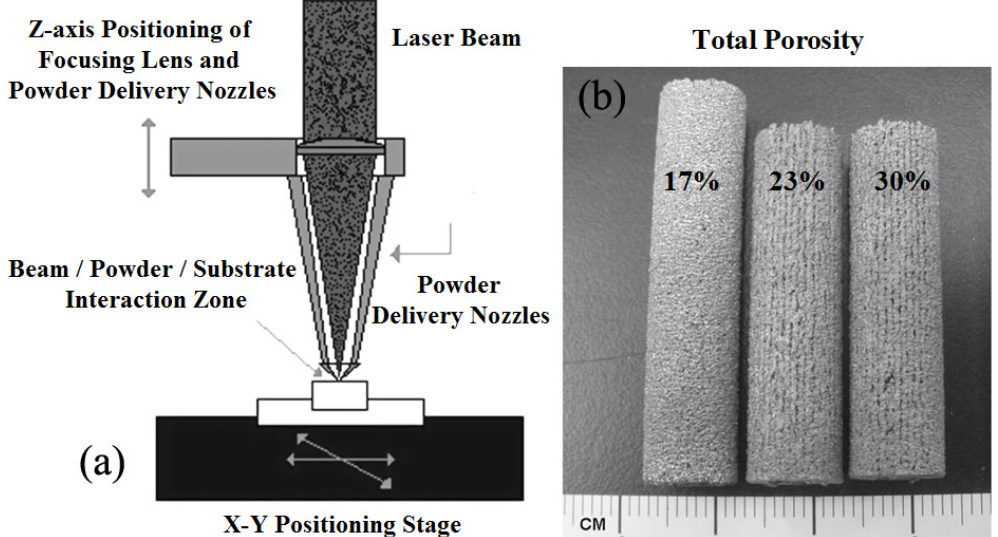
Figure 38. ( a ) Schematic depiction of the laser engineered net shaping (LENS) process; ( b ) typical porous Ti-6Al-4V samples fabricated using LENS [342]. Reprinted with permission from [342]. Copyright 2010